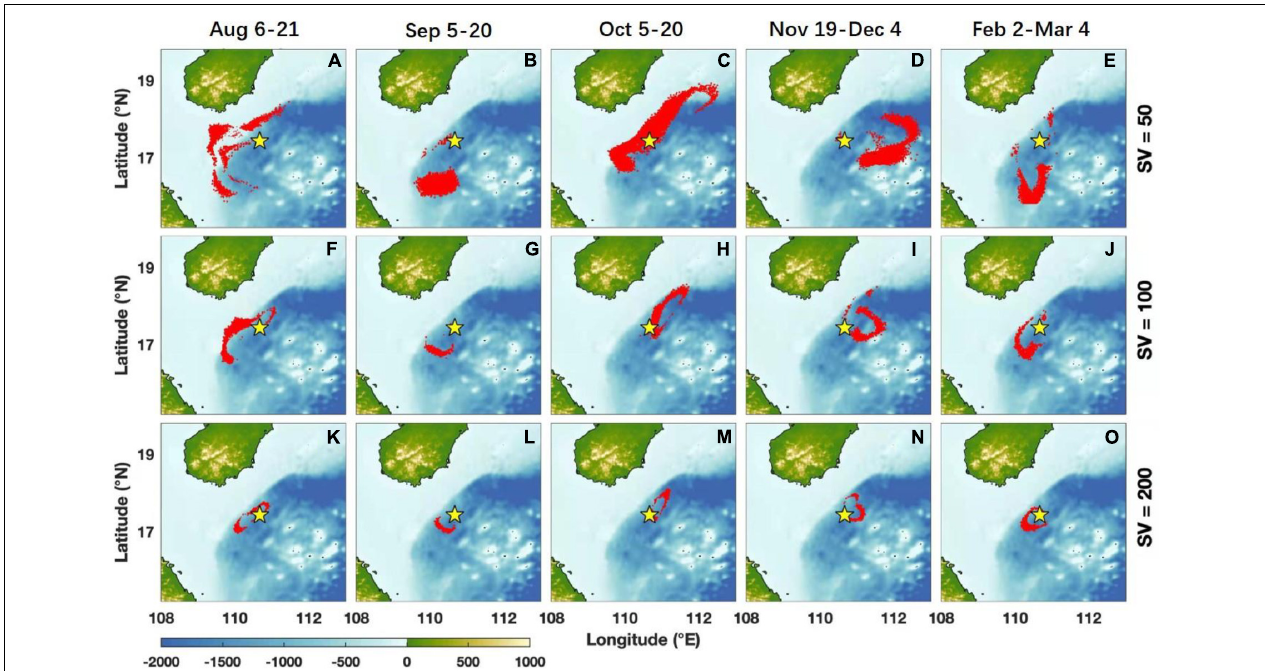
FIGURE 5 | Source regions calculated by LPTM backtracking for sinking particles released at a water depth of 1,000 m with different sinking velocities (sv) (upper panel A–E : sv = 50 m · day − 1 ; middle panel F–J : sv = 100 m · day − 1 ; and lower panel K–O : sv = 200 m · day − 1 ).